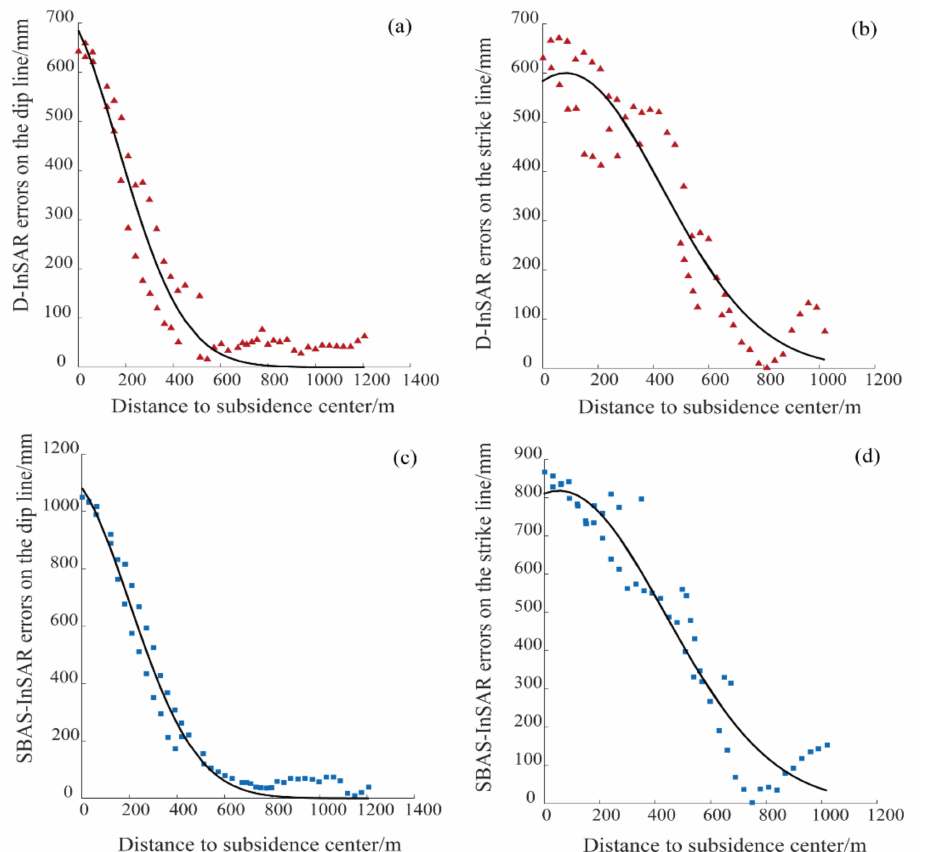
Figure 11. The fitting curves between the distance from the leveling observation point to the subsidence center and InSAR-monitored errors: ( a ) D-InSAR fitting curve on the dip line; ( b ) D-InSAR fitting curve on the strike line; ( c ) SBAS-InSAR fitting curve on the dip line; ( d ) SBAS-InSAR fitting curve on the strike